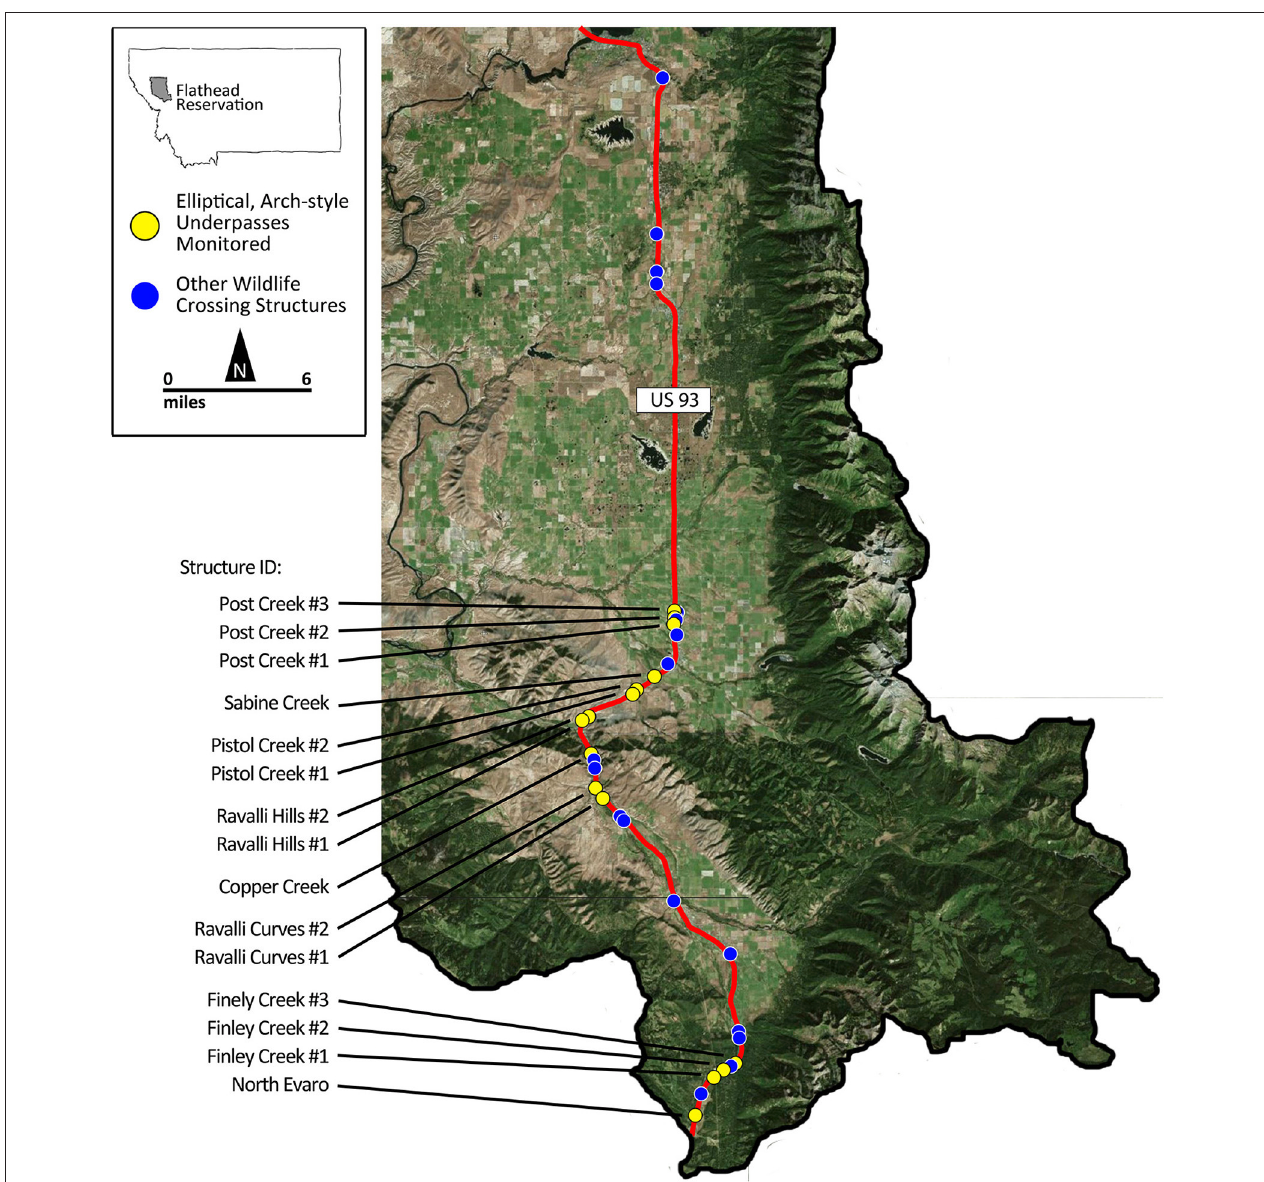
FIGURE 1 | The location of the wildlife crossing structures along US Highway 93 on the Flathead Indian Reservation in western Montana, USA. Structures monitored as part of this study are indicated as yellow circles. Other wildlife passage structures not included in this study are indicated as blue circles. US Highway 93 is